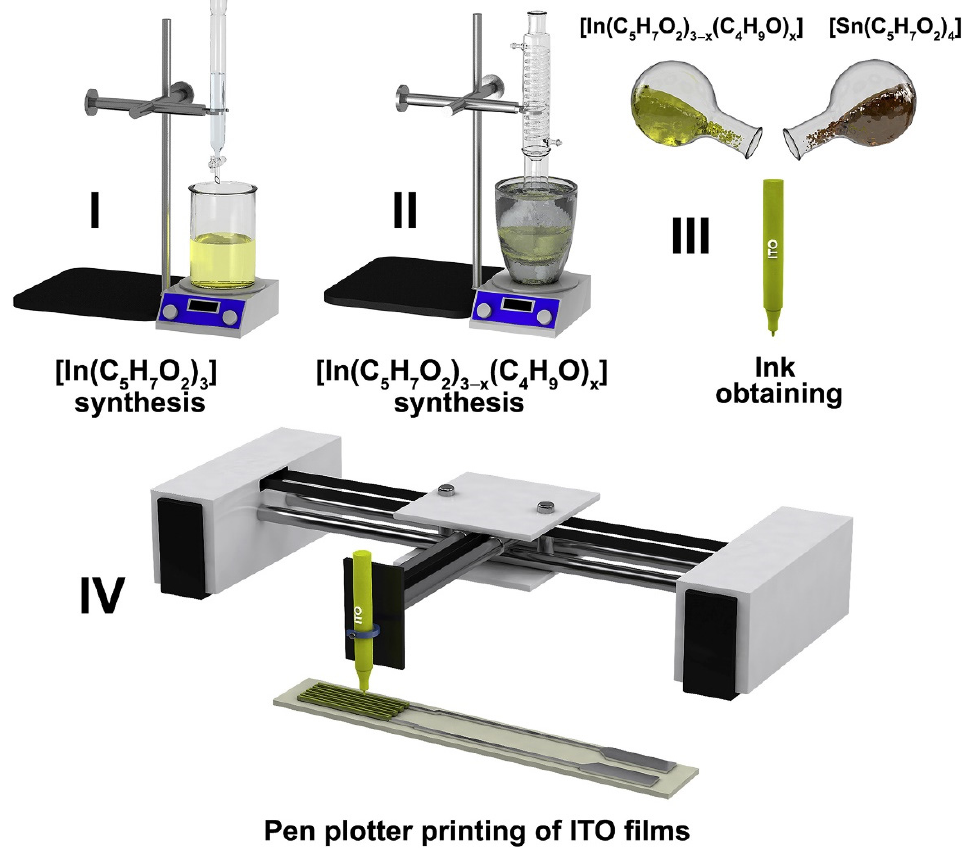
Figure 6. Scheme of the ink obtaining and pen plotter printing of ITO films. Reproduced from ref. [102]. Copyright 2021, Elsevier,